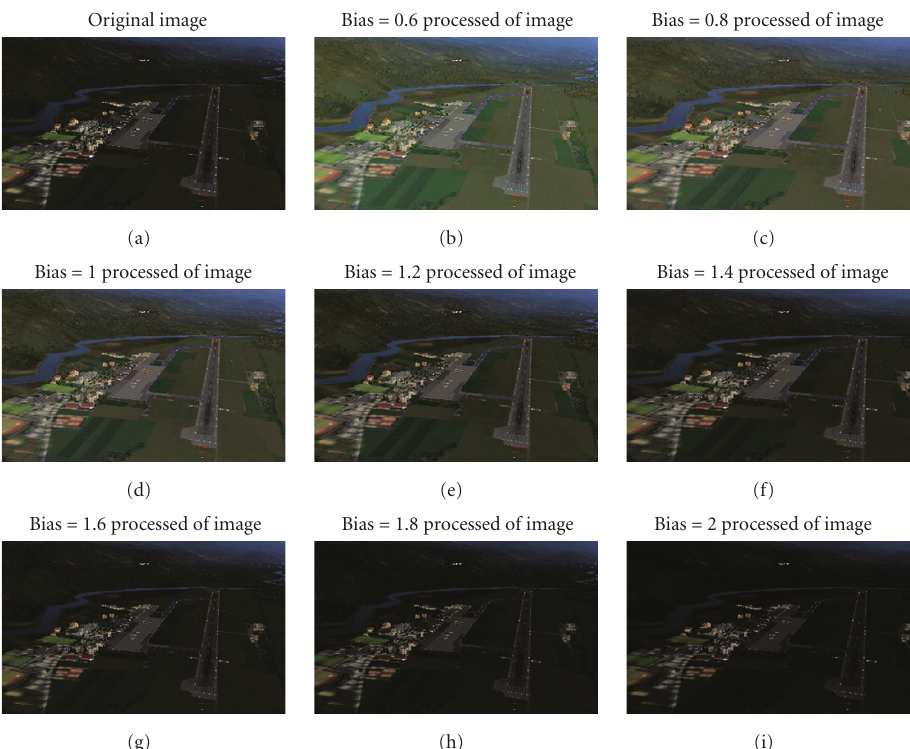
Figure 21: (a) is a bad contrast image, (b)–(i) illustrate results using the proposed method with di ff erent factors, yielding di ff erent scales of enhanced image